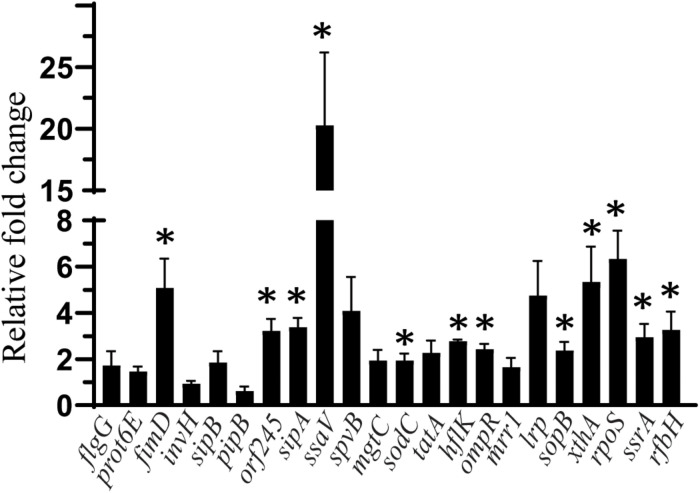
The effect of SIC 45 mM of SB on the expression of SE genes crucial for virulence and intestinal colonization. Data presented as relative fold change normalized to endogenous control, 16S rRNA. * indicates significant change in the expression of genes at P < 0.05.